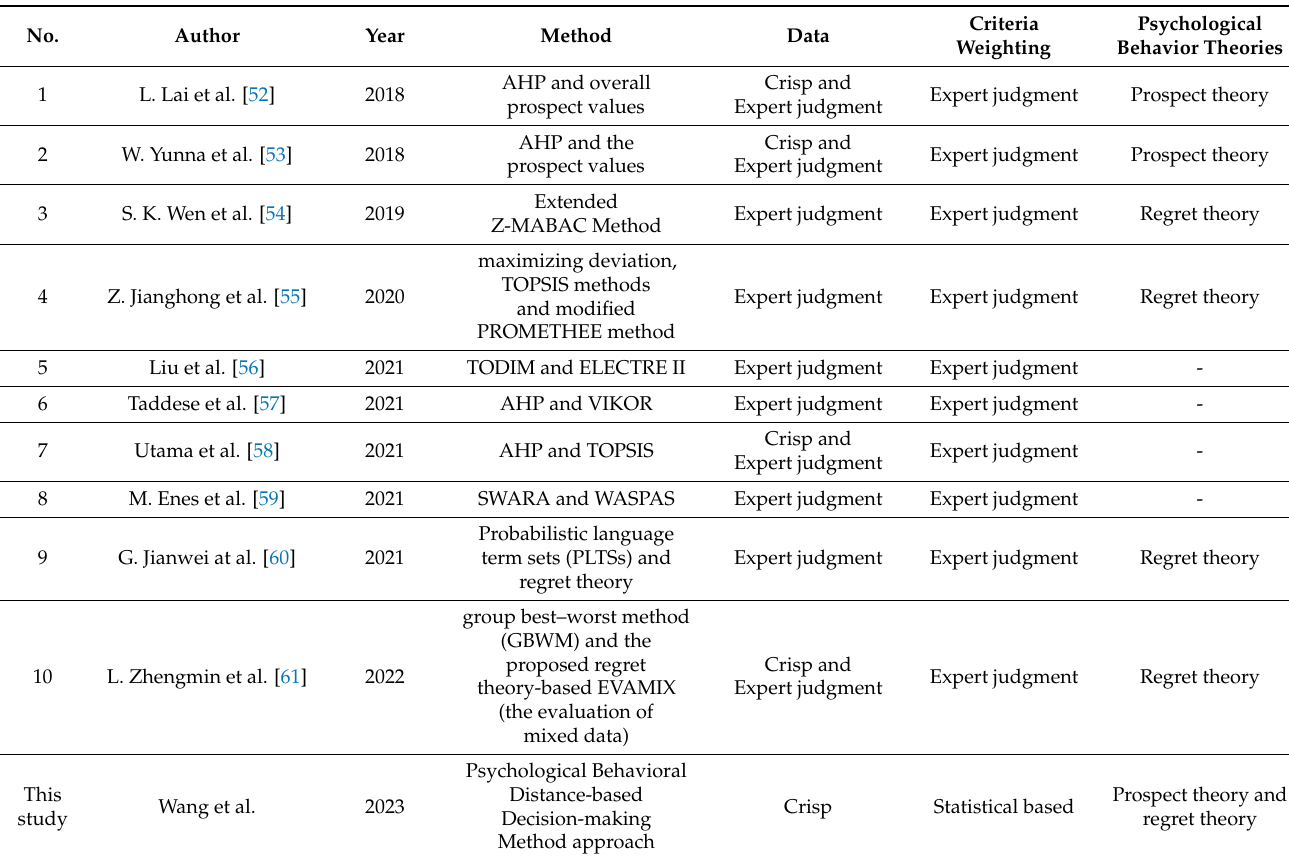
Table 1. Previous relevant